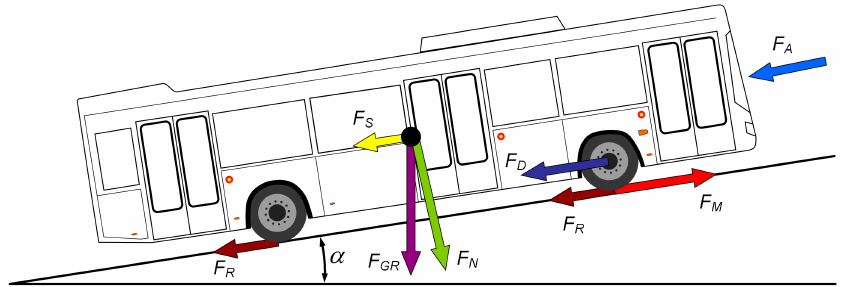
Figure 3. Forces acting on a moving electric drive